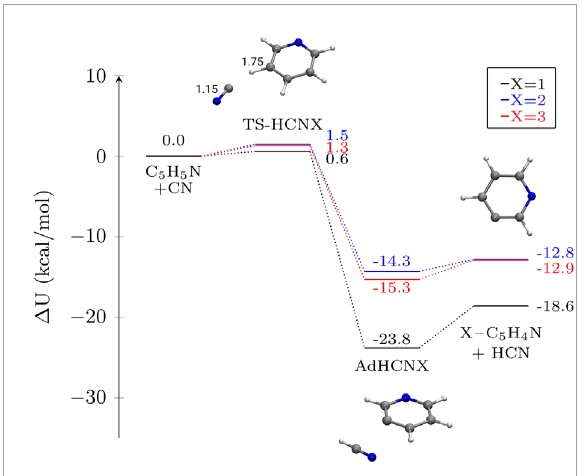
FIGURE 4 Potential energy profiles for the formation of HCN and X-pyridil ( X – C 5 H 4 N ) from pyridine and CN via a H abstraction in different atomic positions. The depicted magnitude is Δ U (electronic energy + ZPVE) in kcal mol −1 . Molecular structures of the stationary points on the different PES other than pyridine are shown for X = 2 as an example. Distances are given in